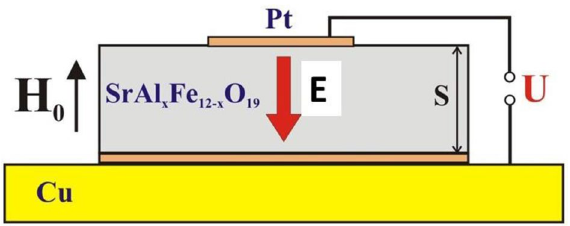
Figure 1. Schematic diagram of the experimental measurement